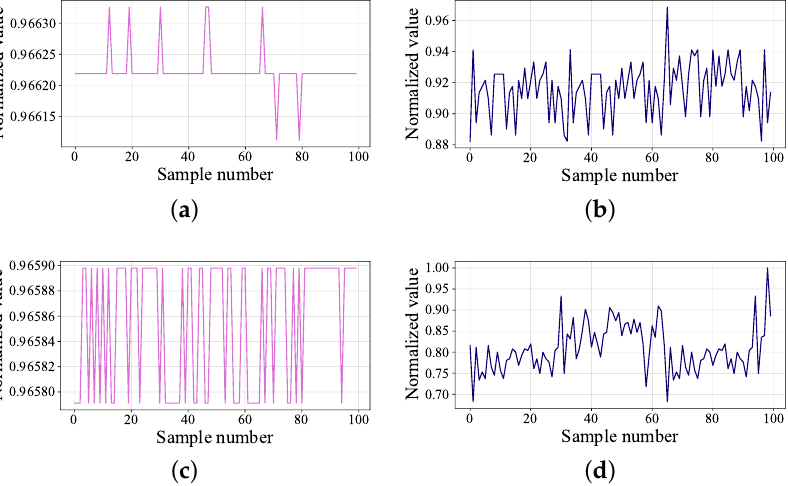
Figure 12. Real data and generated data: ( a ) real normal data of temperature of tank VP2; ( b ) generated normal data of temperature of tank VP2; ( c ) real fault data of temperature of tank VP2; ( d ) generated fault data of temperature of tank VP2.